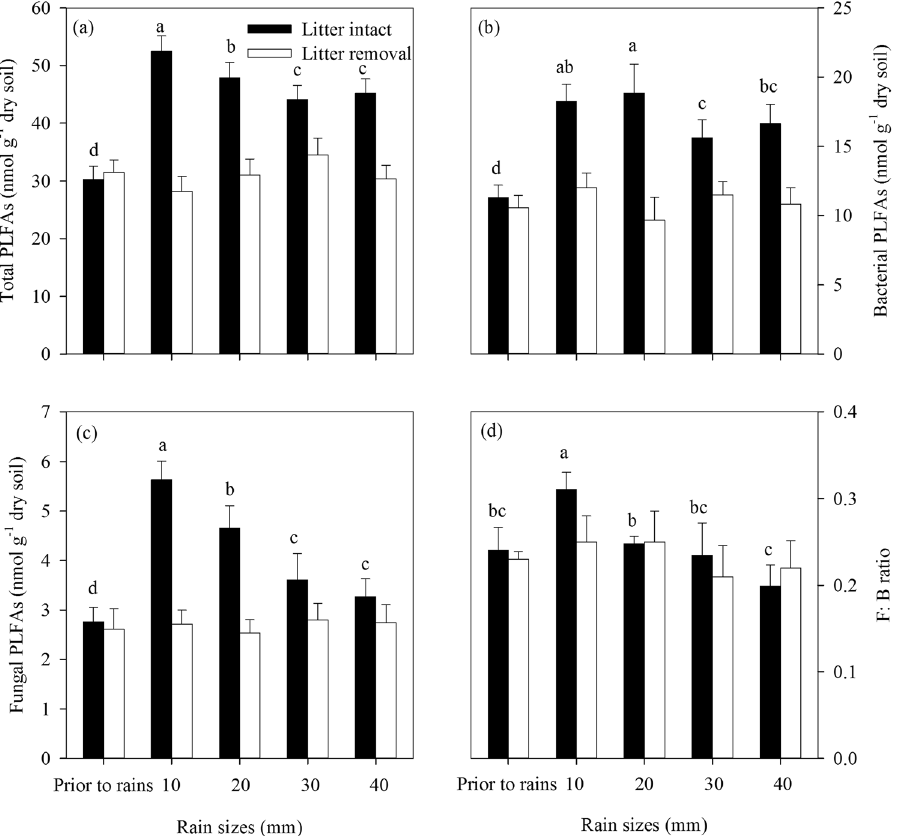
Figure 3. Soil microbial PLFA biomass (nmol g − 1 dry soil) prior to and after simulated rains with different rain sizes. Values are means ± SE (n = 5). F: B indicates the ratio of fungal to bacterial PLFAs. Different letters over the bar indicate statistically significant differences in the litter plots. No significant difference in soil microbial PLFAs among the rain sizes was found in the bare